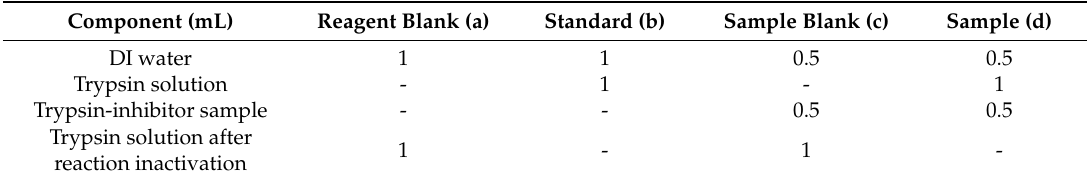
19: Constant figure based on the absorbance given by 1 mg of pure trypsin m%: moisture content of defatted Gac seed kernel powder or freeze-dried extract powder Table 2. Reagent composition in extracted